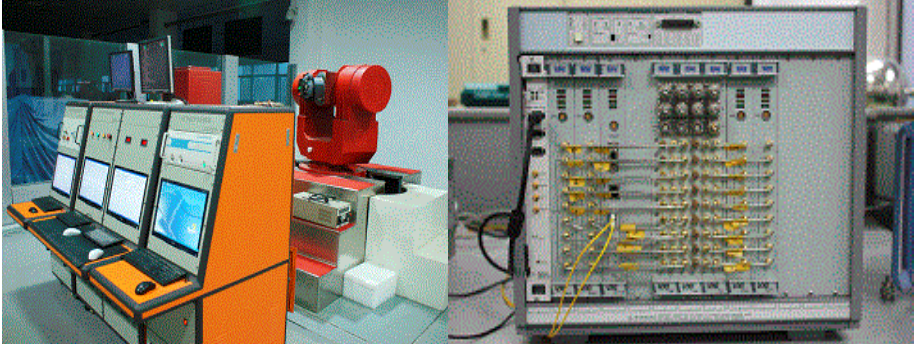
Figure 8. Simulation experiment system setup.